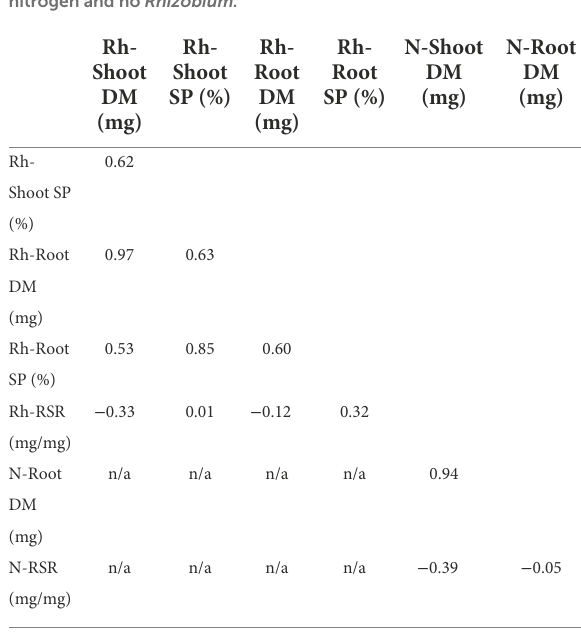
TABLE 2 Multi-trait analysis of variance (MANOVA) genetic correlation coefficient values between five traits of 120 white clover half-sib families inoculated with the Rhizobium leguminosarum bv. trifolii strain TA1, and between three traits when supplemented with mineral nitrogen and no